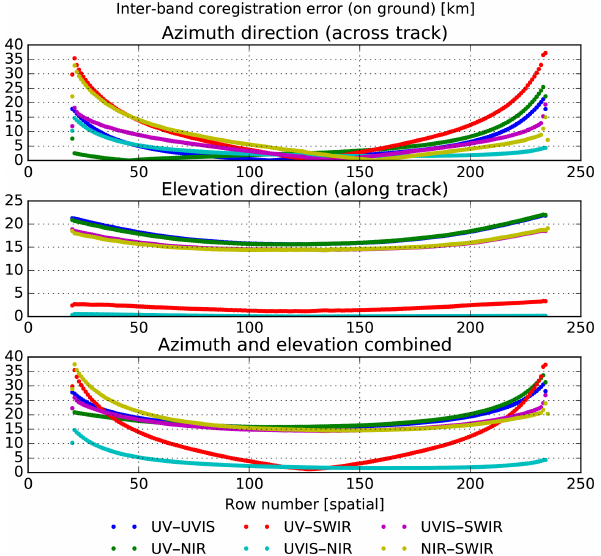
Figure 33. Inter-band co-registration error as distance on the sur- face of the Earth (km) versus row number (spatial direction), for all detector combinations. For UVN, the average of four adjacent rows is taken for comparison to one SWIR row. The large differences be- tween UVIS–NIR and UV–SWIR in the elevation direction are as expected from the slit